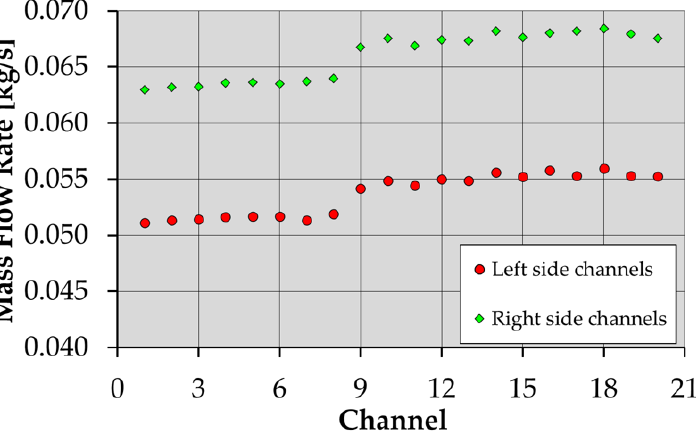
Figure 12. Coolant MFR distribution in the BZ DWTs (inlet to recirculation manifolds).